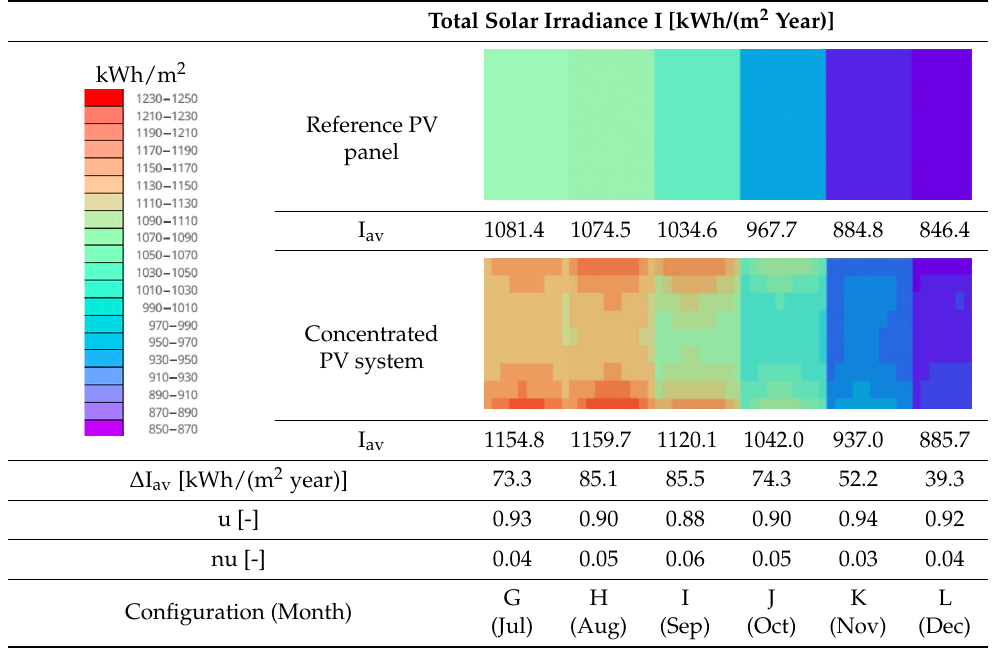
Table 6. Solar irradiance characteristic for G–L cases of PV panels positioned vertically. Table 5. Solar irradiance characteristic for A–F cases of PV panels positioned